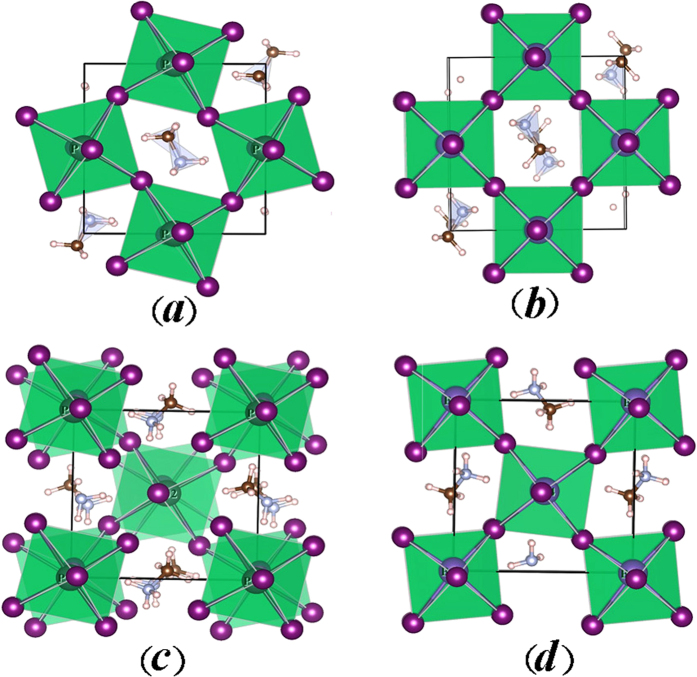
The projection diagrams of O-CH3NH3PbI3 in (010) plane (a), O-CH3NH3BiI3 in (010) plane (b), T-CH3NH3PbI3 in (001) plane (c), and T-CH3NH3BiI3 in (001) plane (d).